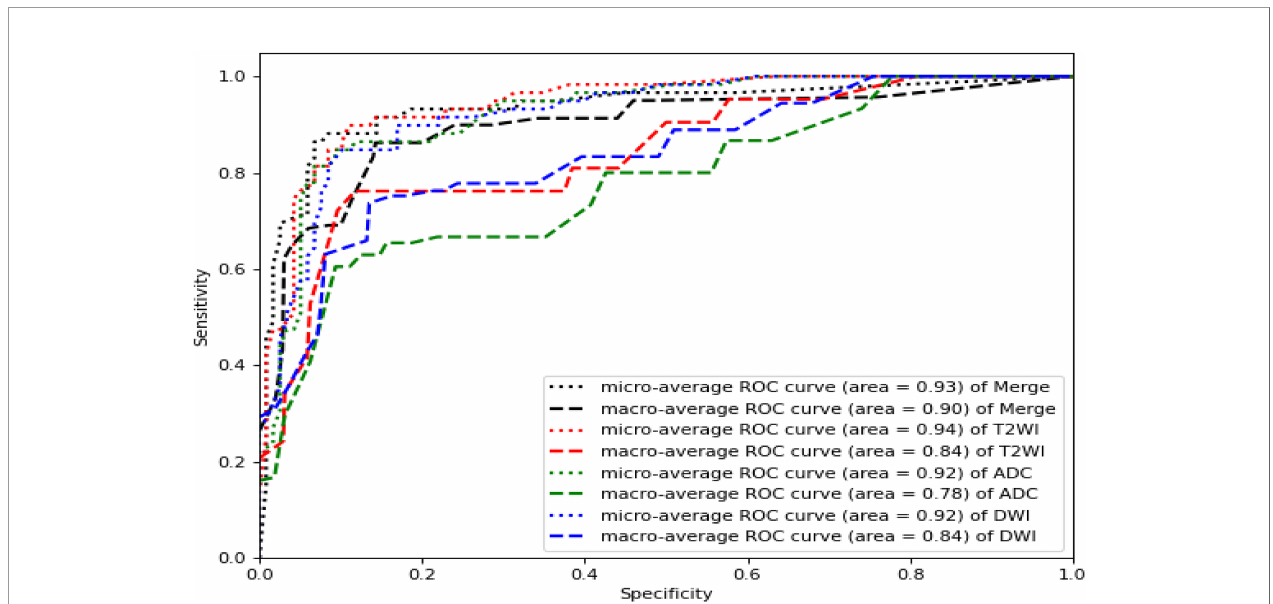
FIGURE 6 | ROC curves of the RF models established by T2WI (red), DWI (blue), ADC (green) and merged sequences (black). The corresponding areas under the micro-average ROC curves were 0.94, 0.92, 0.92, and 0.93, respectively. The corresponding areas under the macro-average ROC curves were 0.78, 0.84, 0.84 and 0.90,